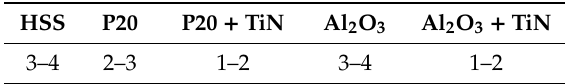
Table 13. Values of K RM constant—T-v c